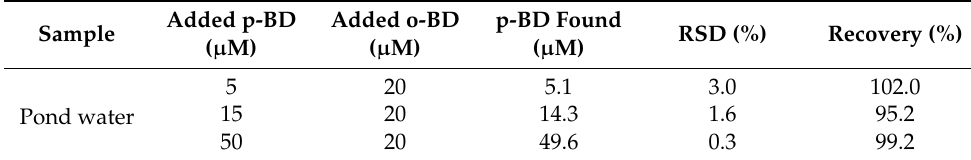
Table 2. Determination of o-BD in pond water sample in the presence of p-BD.